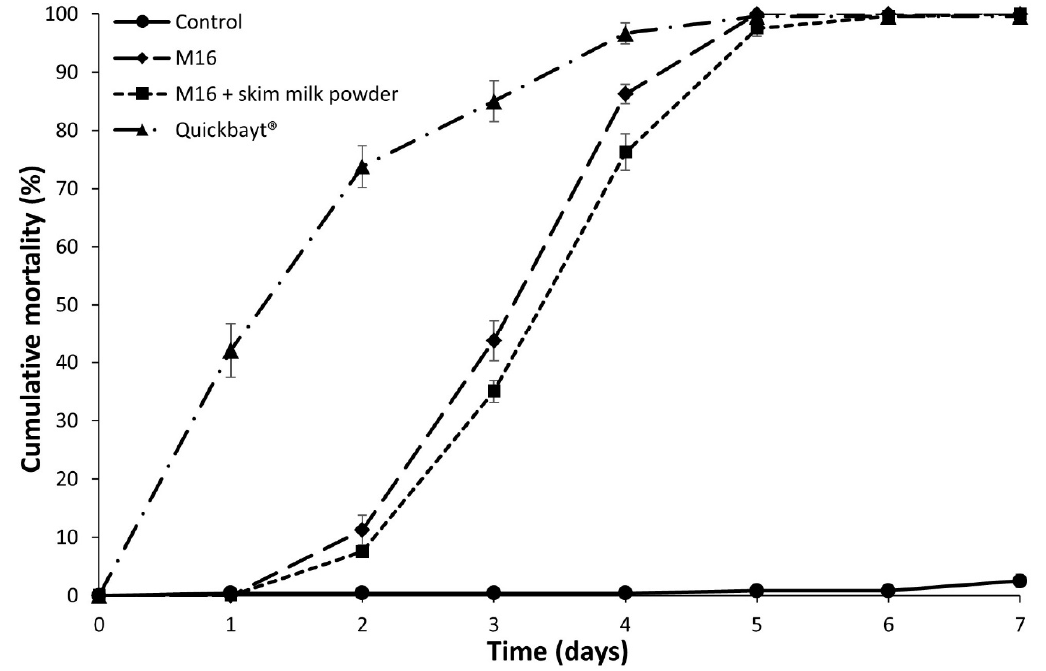
Figure 3. Cumulative mortality ( ± SE) of Musca domestica following exposure to a commercial imidacloprid fly bait (Quickbayt ® ) and mycoinsecticide baits containing Metarhizium anisopliae . All survival curves are significantly different.